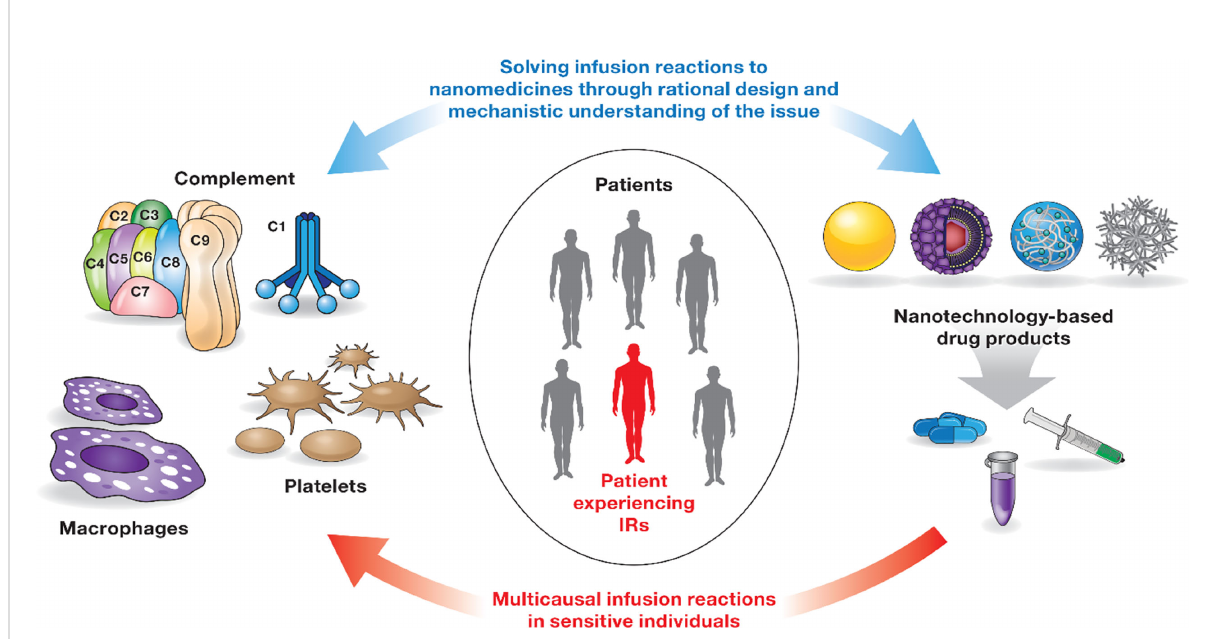
FIGURE 2 Infusion reactions to nanomedicines. IRs to nanomedicines involve multiple players (immune cells, coagulation, and complement systems) and complex, often overlapping mechanisms. Not all patients are sensitive to these responses. Interaction between one or several components of the immune system and the nanocarrier triggers these responses in sensitive individuals. Timely detection and appropriate management of